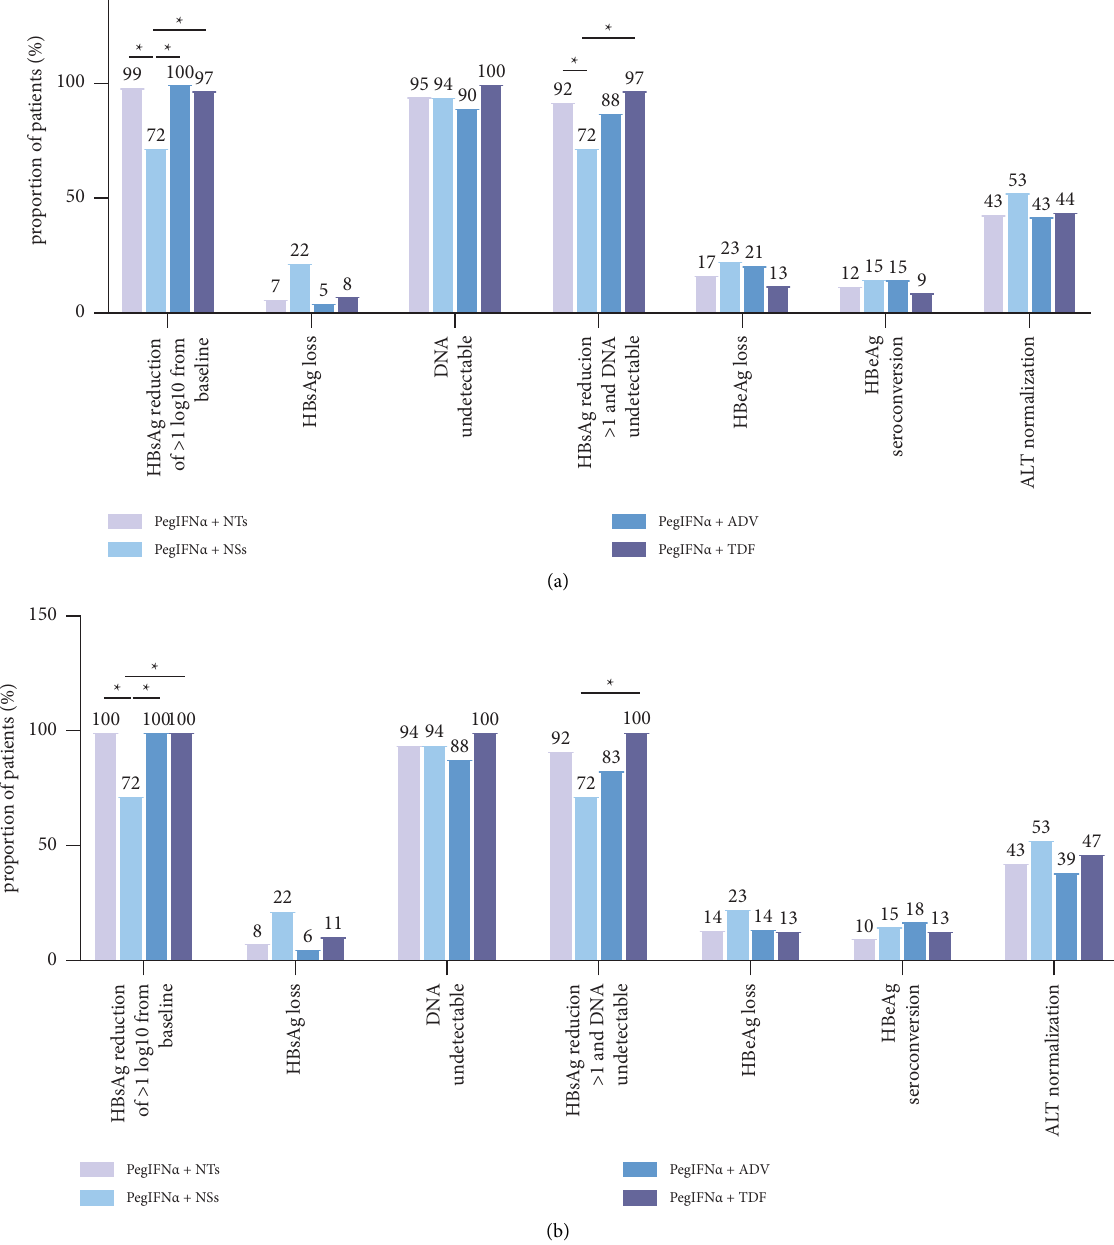
Figure 3: Te rate of diferent indicators at the end of therapy. (a) Efcacy index before propensity score matching; (b) efcacy index after propensity score matching. P < 0 .